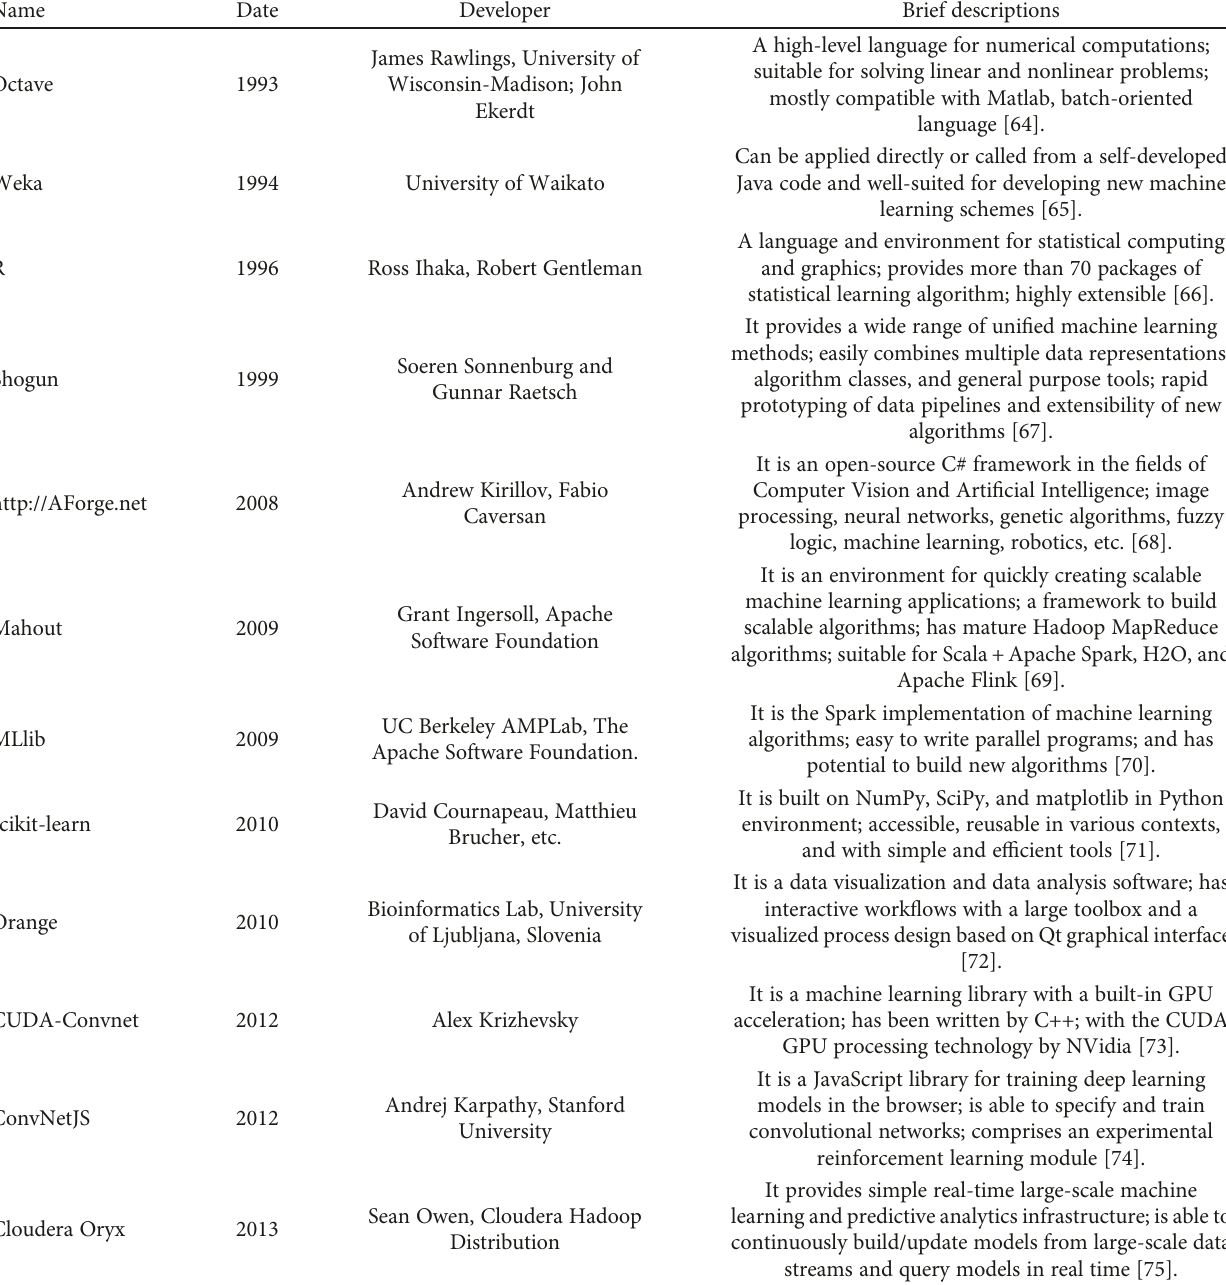
Table 1: Open-source/free software of Big Data machine learning method brief